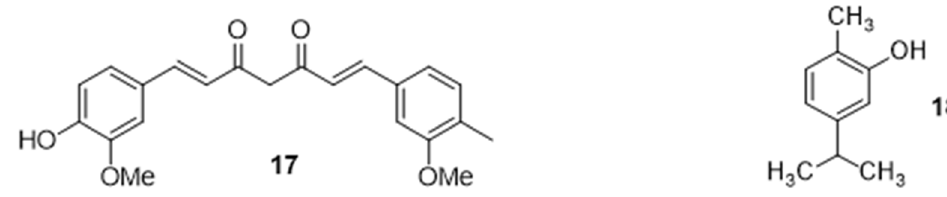
Figure 6. Structure of curcumin 17 and carvacrol 18 Figure 6 . Structure of curcumin 17 and carvacrol 18 .